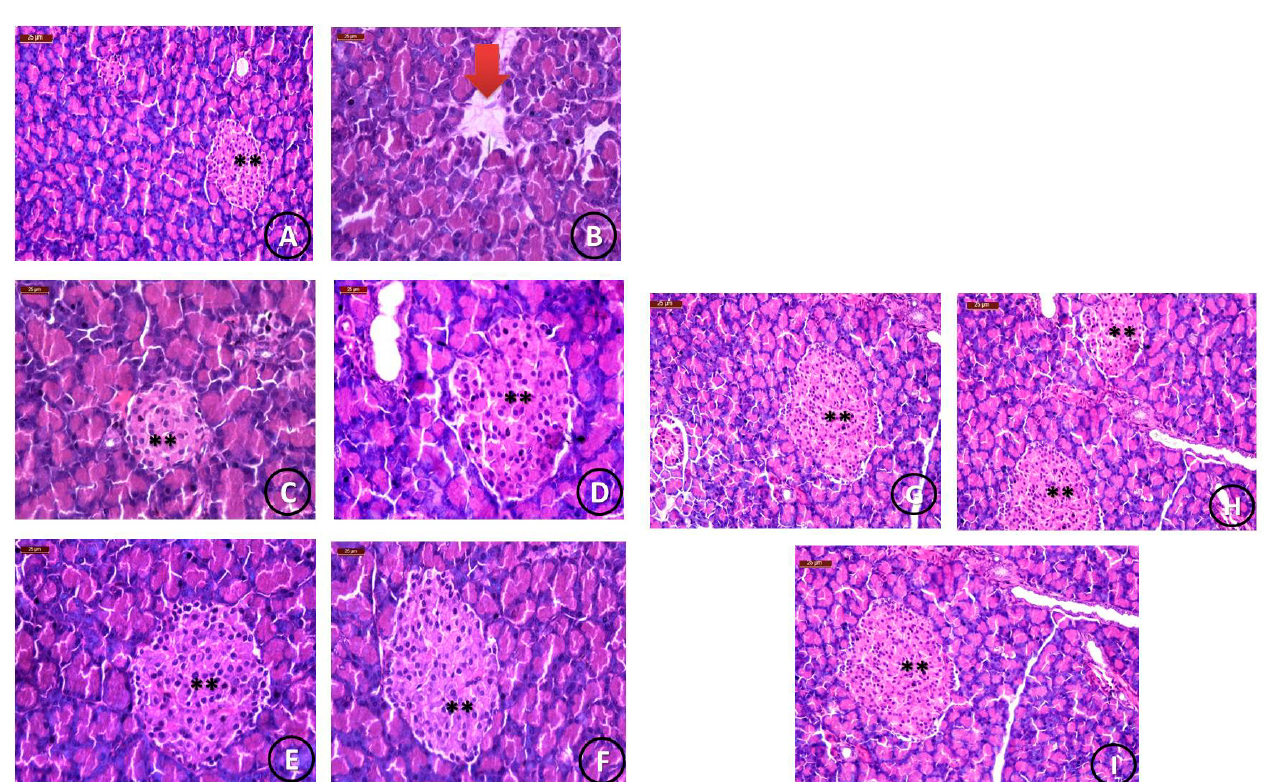
Figure 6. Histological photomicrographs of pancreatic tissues. ( A ) Normal pancreatic parenchyma and the normal appearance of islets of Langerhans (**) (scale bar = 25 μ m). ( B ) STZ group showing detached pancreatic parenchyma (**) with the disappearance of islets of Langerhans (red arrow) (scale bar = 25 µ m). ( C ) STZ and STG group showing the restoration of detached pancreatic parenchyma with moderately sized islets of Langerhans (**) (scale bar = 25 µ m). ( D – I ) STZ and Mg, Cu, Zn, Ca, Cr, and Se/STG groups showing normal pancreatic parenchyma (with the appearance of islets of Langerhans (**) that were greatly enlarged in groups D and F) and enlarged pancreatic islets in group H, which was treated with the Cr/STG novel complex (scale bar = 25 μ m). Table 6. Histopathological findings in the pancreatic tissues of normal rats, untreated diabetic rats, and diabetic rats treated with either STG, Cu/STG, Mg/STG, or Zn/STG. Pancreatic Parenchyma Islets of Langerhans Size Groups Normal Detached Normal Reduced Mild Enlarged